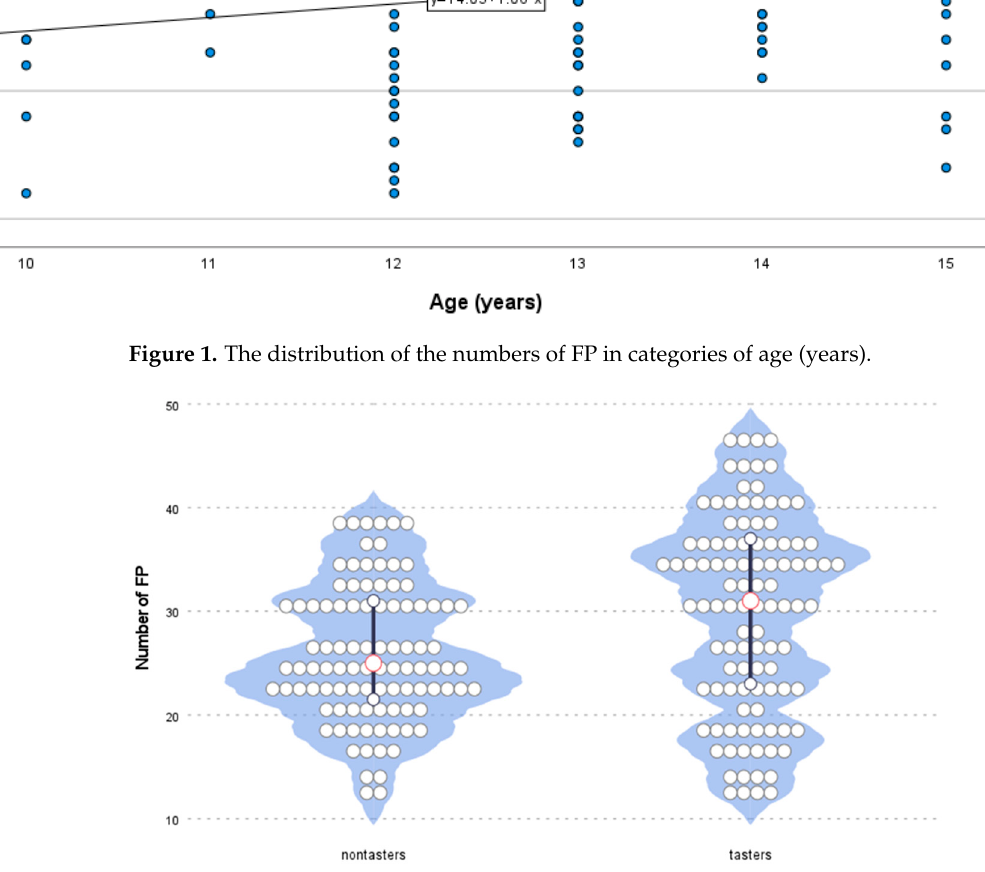
Figure 2. The distribution of the numbers of FP in the categories of tasters/nontasters.